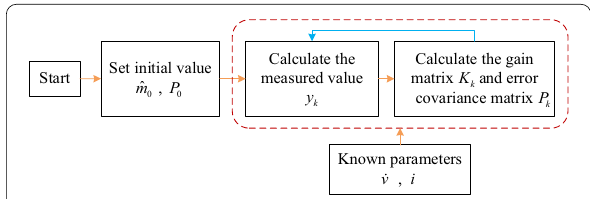
Figure 5 Flow chart of the RLS